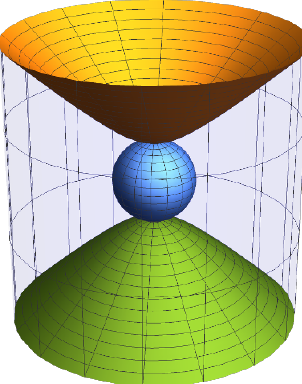
Figure 9. An H 2 brane describes D1-brane segments stretching from the NS5-branes to in(cid:12)nity, while an S 2 brane describes the complementary segment stretching between NS5-branes, when lifted to 10+2 dimensions. In both cases, the azimuthal direction is the orbit of spatial gauge transformations; all points on an orbit project down to the same point in physical spacetime. The brane must also be smeared along the orbits of temporal gauge